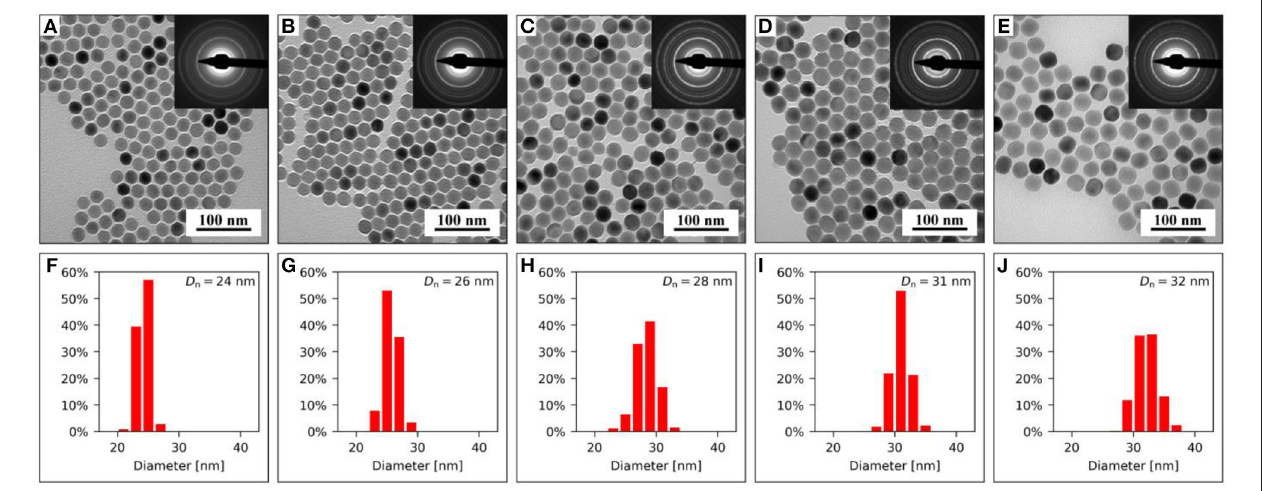
FIGURE 1 | (A–E) TEM/BF micrographs with TEM/SAED diffraction patterns (insets) and (F–J) corresponding particle size distributions of NaYF 4 :Yb 3 + /Er 3 + @NaYF 4 :Nd 3 + nanoparticles containing (A,F) 0, (B,G) 0.1, (C,H) 0.3, (D,I) 0.5, and (E,J) 0.7 mmol of NaYF 4 :Nd 3 + . Number-average particle diameters D n are shown in the upper right corners of the